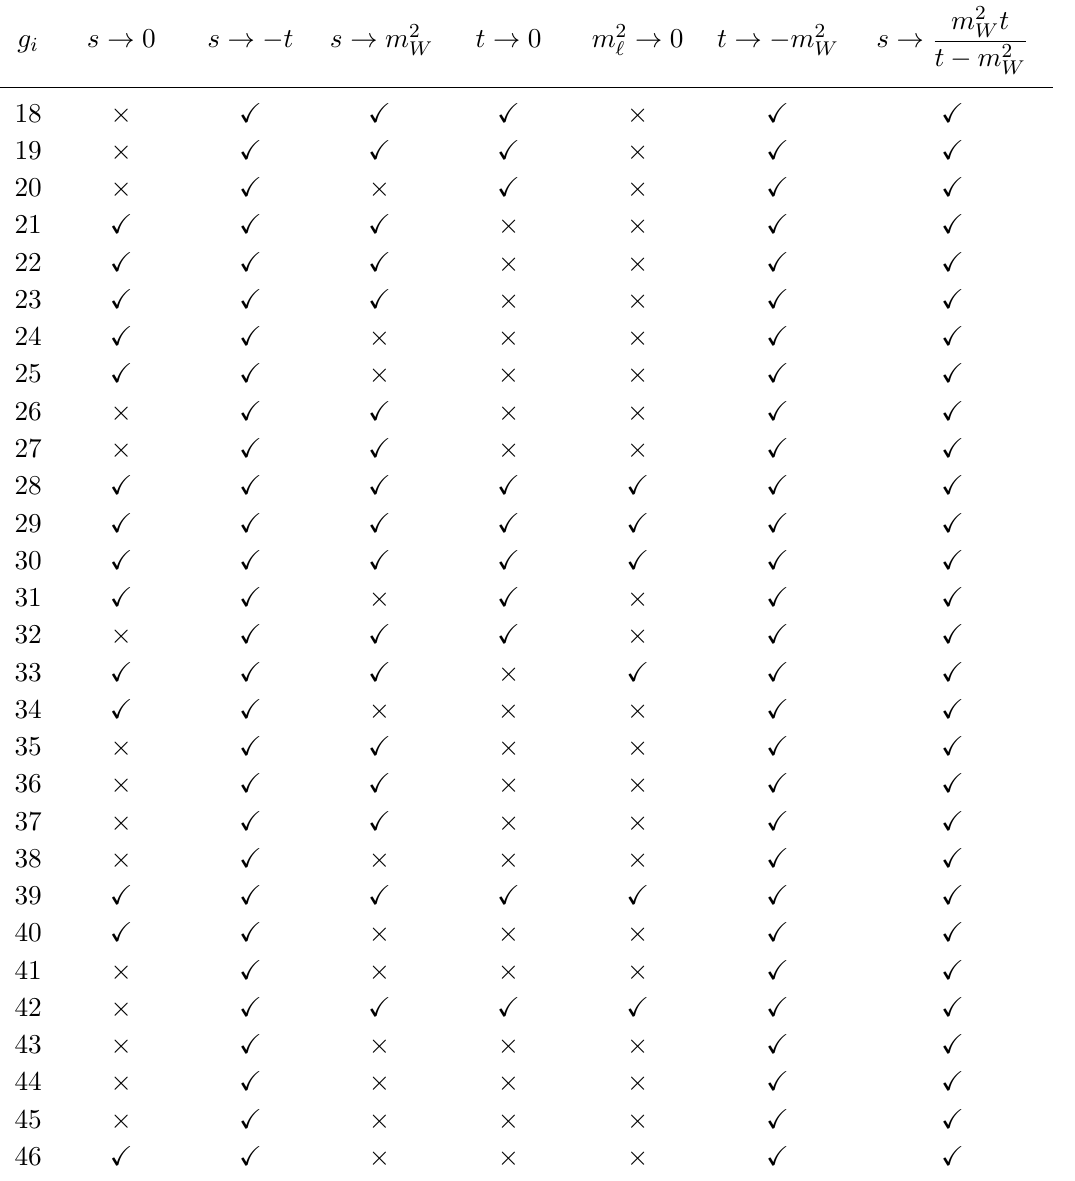
, s → − t , s → m 2 ) , t → 0 , t → − m 2 t/ ( t − m 2 W W W W